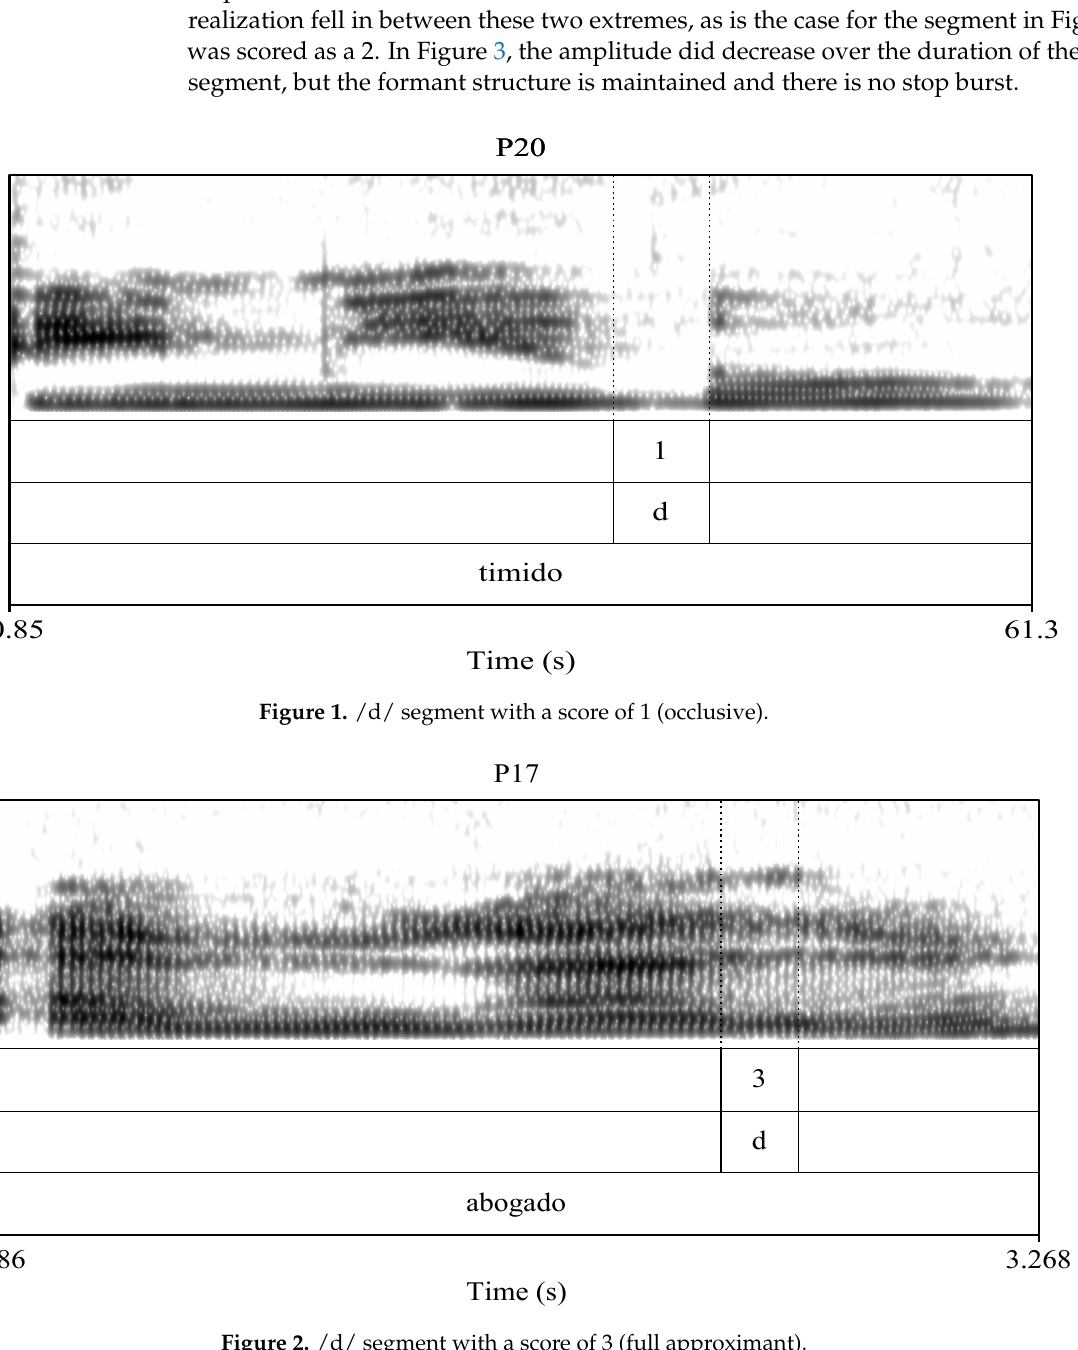
Figure 2. /d/ segment with a score of 3 (full approximant).